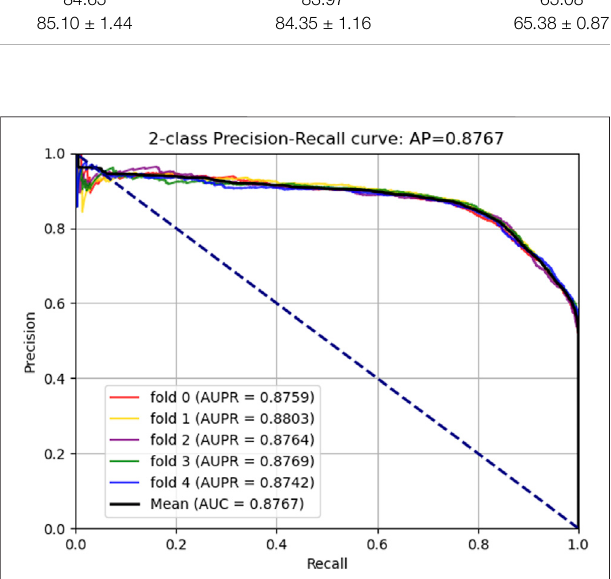
FIGURE 3 | Receiver operating characteristic curves generated by KGDCMI. FIGURE 4 | Area under the precision